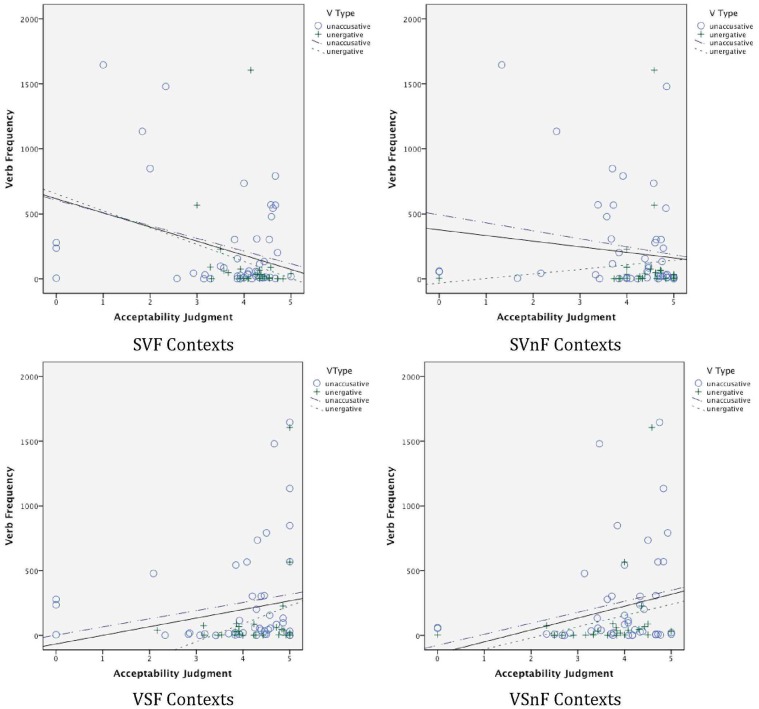
Bilingual judgments.